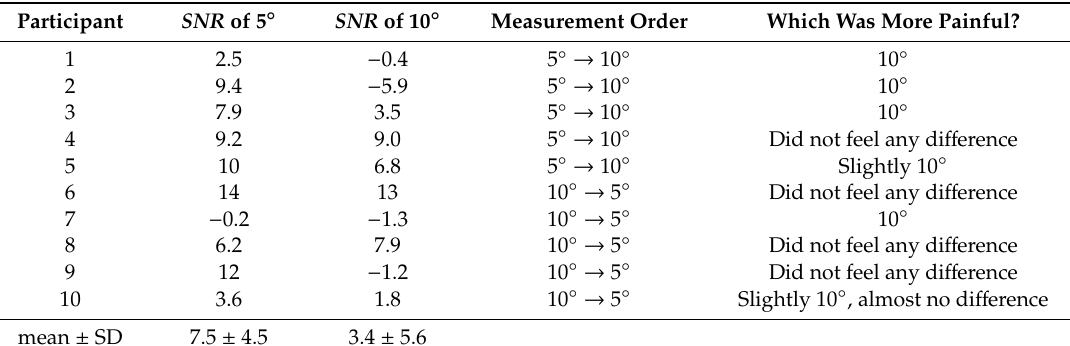
Table 2. SNR and experiences of the participants with respect to the rotation angle.